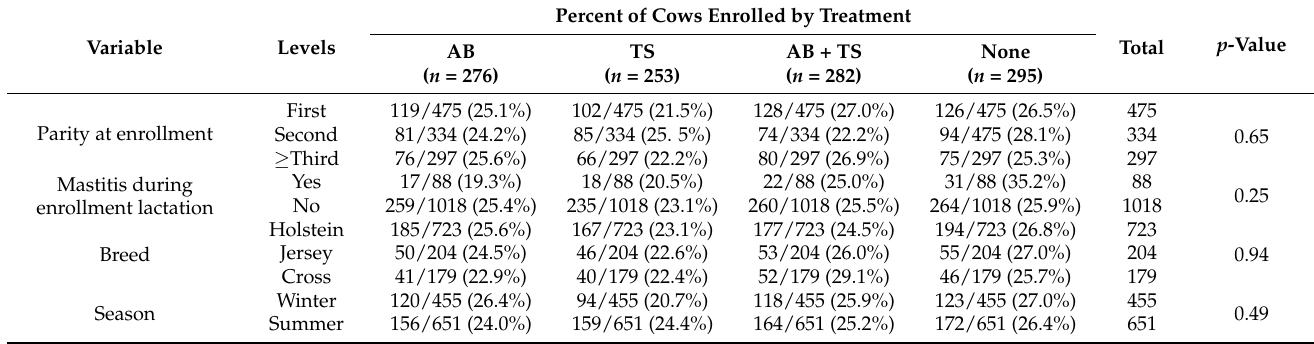
Table 2. Comparison of the categorical variable baseline traits for the enrolled dairy cows ( n = 1106 cows) from 8 herds after allocation to the four treatment groups (AB, TS, AB + TS, None) 1